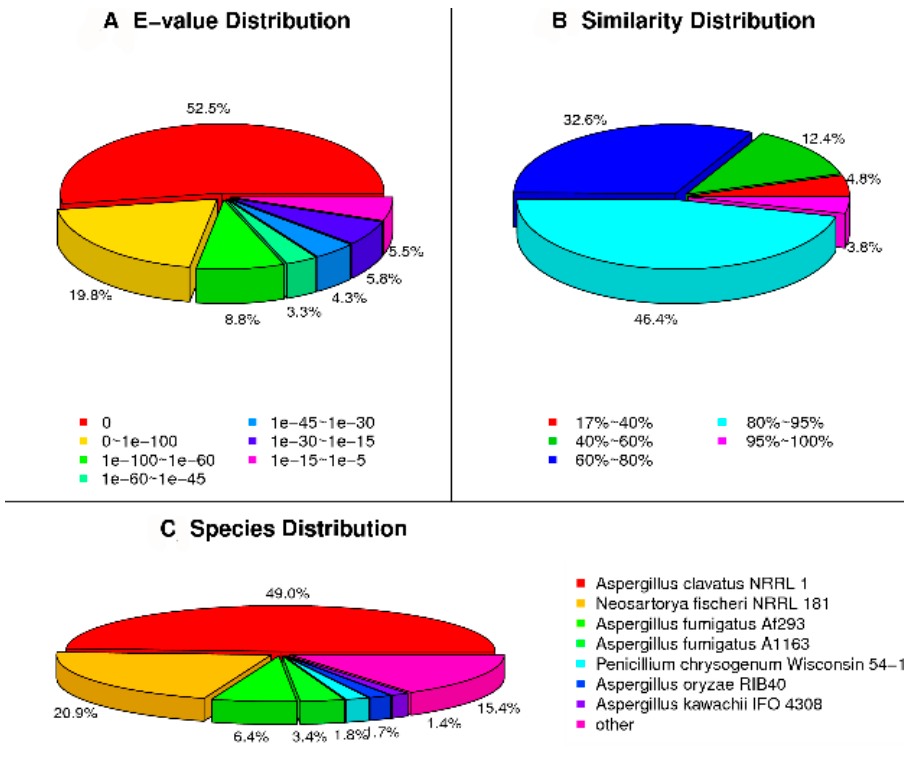
Figure 1. The NR classification of the D. cejpii FS110 transcriptome: ( A ) The E-value distribution; ( B ) The similarity distribution; ( C ) The species distribution.